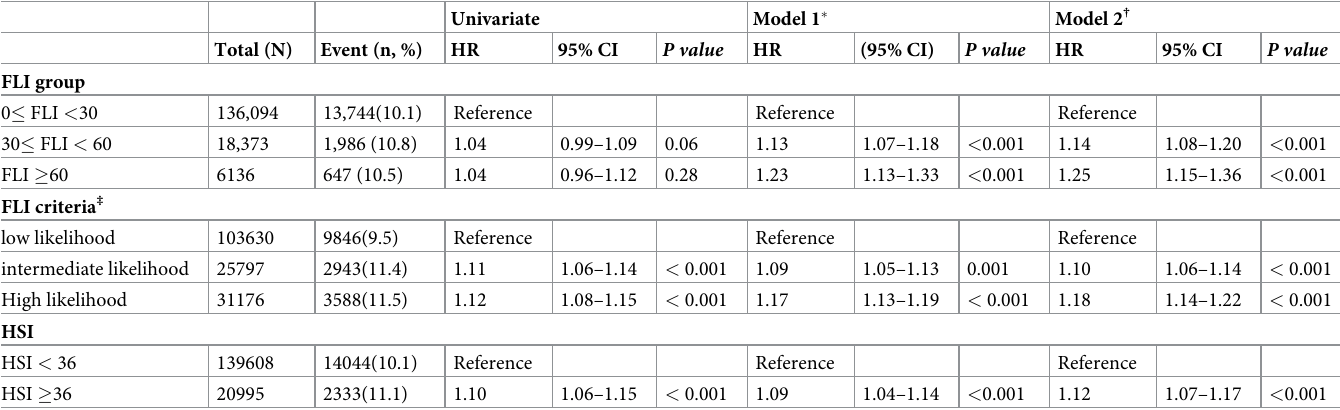
Table 2. Association between fatty liver index and incidence of adult-onset asthma. Univariate Model 1 � Model 2